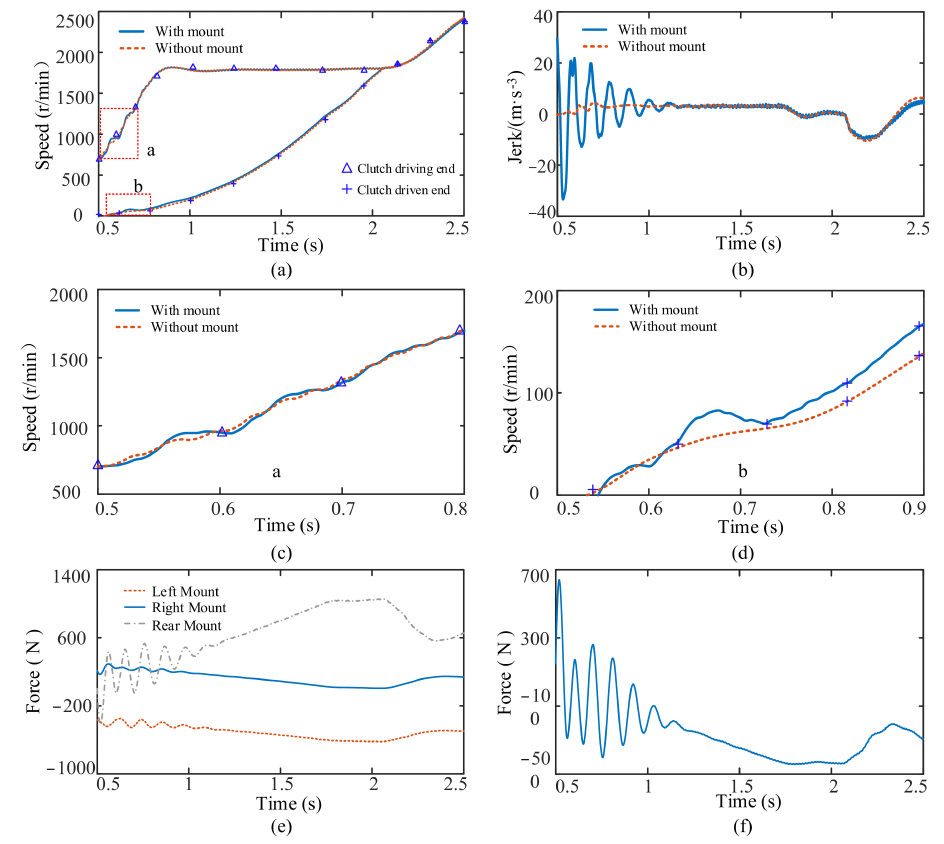
Figure 6. Results of the mount influence on the starting condition: ( a ) clutch speed; ( b ) vehicle jerk; ( c ) the enlarged view of curve a in figure a; ( d ) the enlarged view of curve b in figure a; ( e ) longitudinal force of each mount; ( f ) the longitudinal force of the powertrain on the